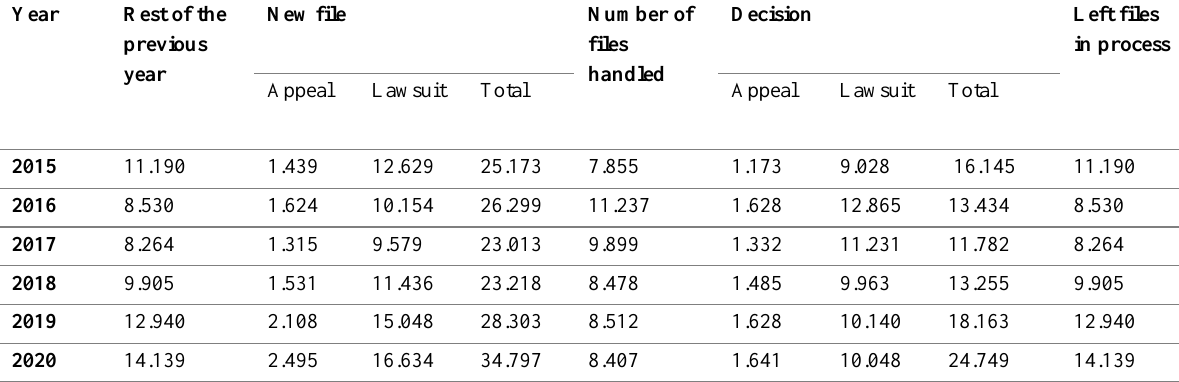
Table 1: List of Files Still in the Process of Handling Tax Disputes (as of December